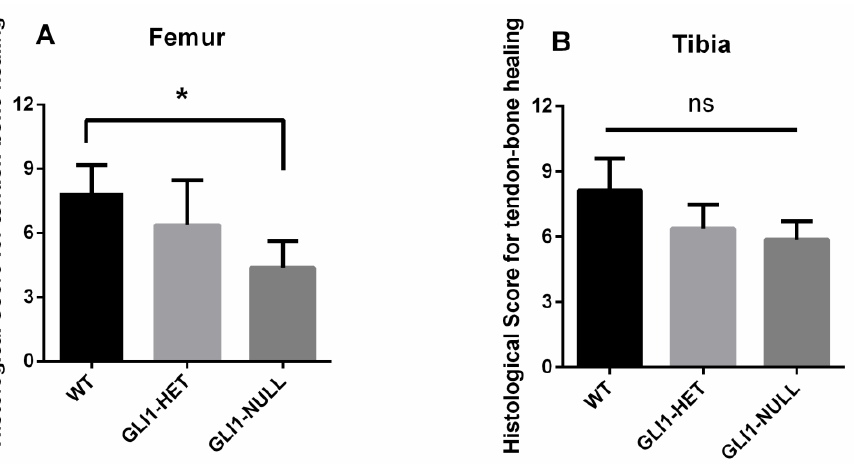
Figure 6. Histologic scores for tendon–bone healing at femoral ( A ) and tibial ( B ) sides in wild-type, GLI1-HET and GLI1-NULL mice at 4 weeks after ACLR. Values are presented as mean ± SD. The WT group had a significantly higher score on the femoral side when compared with the GLI1-NULL group ( p =